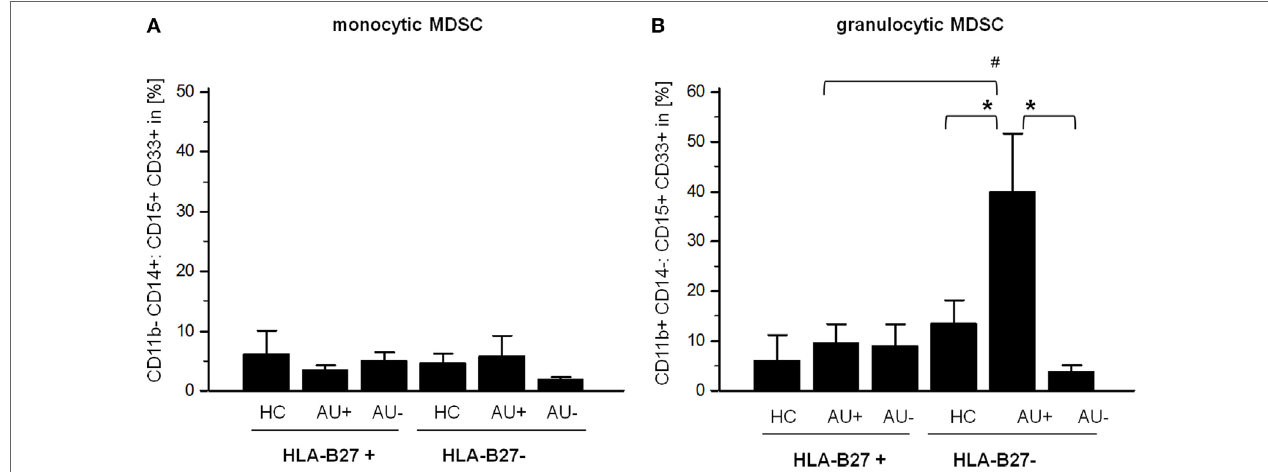
FigUre 3 | Frequency of (a) monocytic myeloid-derived suppressor cells (MDSC) CD11b + CD14 + :CD15 + CD33 + and (B) granulocytic CD11b + CD14 − :CD15 + CD33 + MDSC in peripheral blood of HLA-B27-positive/-negative healthy controls (HCs), and patients with active (AU + ) and inactive (AU − ) anterior uveitis analyzed by flow cytometry (* p < 0.05; Kruskal–Wallis test; # p < 0.05; Mann–Whitney U